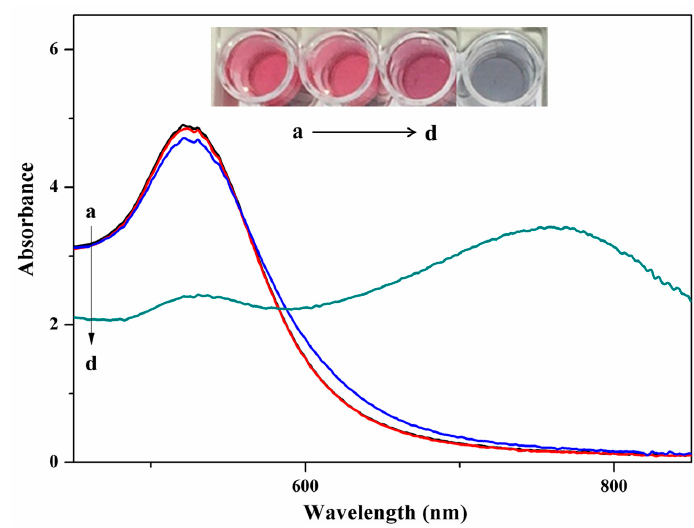
Figure 1. (a) AuNPs (black line), (b) AuNPS with 2.0 mg/L chlorsulfuron (red line), (c) AuNPS with 2.0 mg/L chlorsulfuron and 2.0 mg/L acetamiprid (blue line), (d) AuNPS with 20 mg/L acetamiprid (green line).